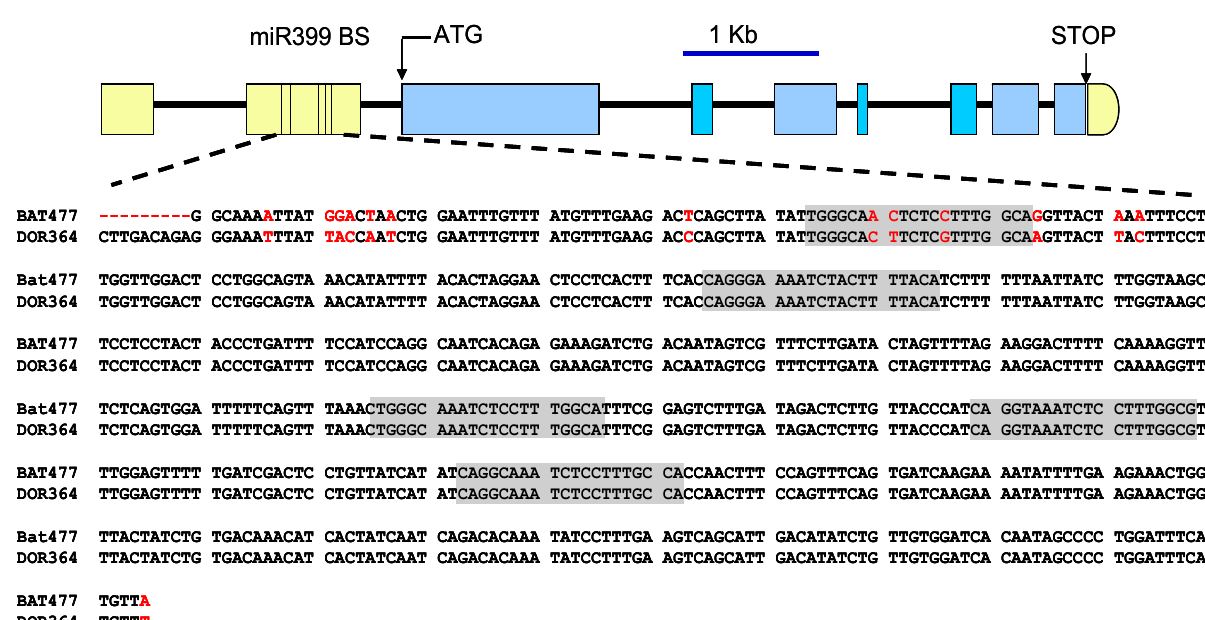
Figure 4. Gene structure of PHO2 gene from the common bean. Introns are represented by black lines, and exons are represented by yellow boxes for UTRs and by blue boxes for coding regions. The ticks in the second exon of the 5' UTR depict the position of the five predicted PvmiR399 binding sites. The 605 bp DNA sequence of the region flanking the predicted PvmiR399 binding sites of the BAT477 and DOR364 genotypes is shown; nucleotides that differ among the two genotypes are marked in red, and the sequences complementary to PvmiR399 are shaded